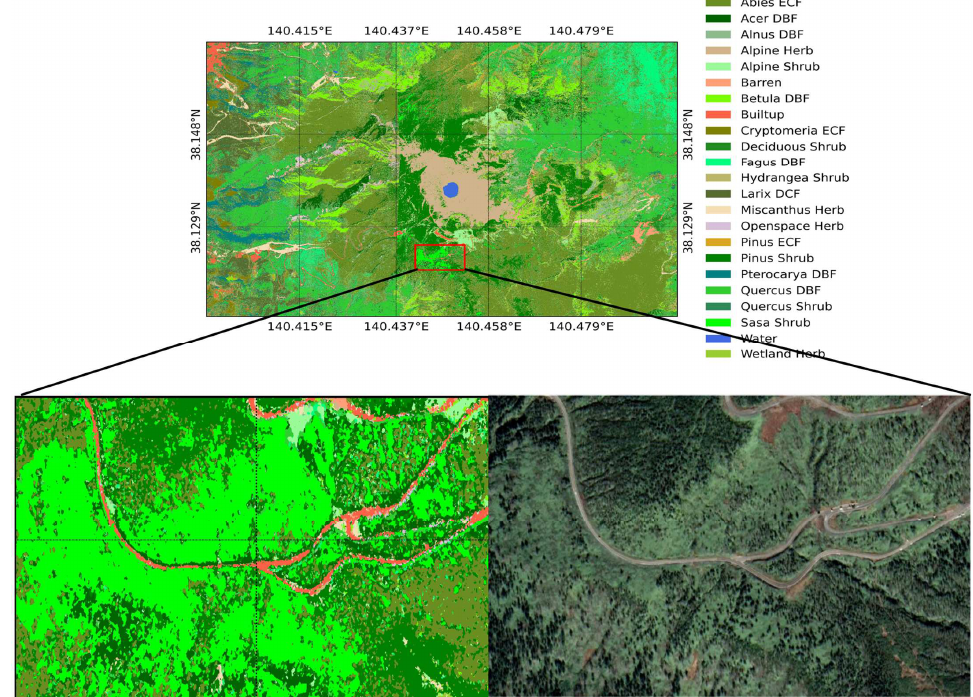
Figure 17. Ultra-resolution map with 23 classes produced for the Zao site ( top ). The red polygon area has been zoomed in to show finer details ( bottom left ) along with the true-color composite image ( bottom right ). In Figure 17, the zoomed-in map (bottom left) shows the distribution of Abies ECF (olive color) and Pinus Shrub (dark green) among the Sasa Shrub (lime color) with built- up areas (red color). This distribution is well matched with the true-color composite image (bottom right). The dark green trees are Abies ECF and Pinus Shrub in the true-color com- posite image, whereas the light green shrubs are Sasa Shrub.